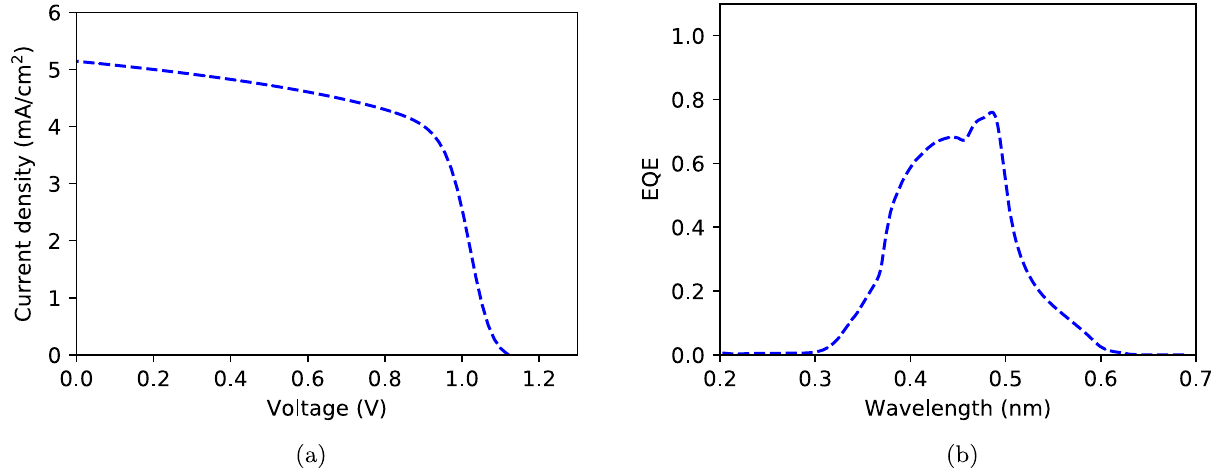
Fig. 4. Characteristics of the AZO/Zn 1 (cid:1) x Ge x O/Cu 2 O solar cell using typical physical parameters obtained by the spray pyrolysis process for the Cu 2 O absorber layer. (a) Current-Voltage characteristics. (b) External quantum ef fi